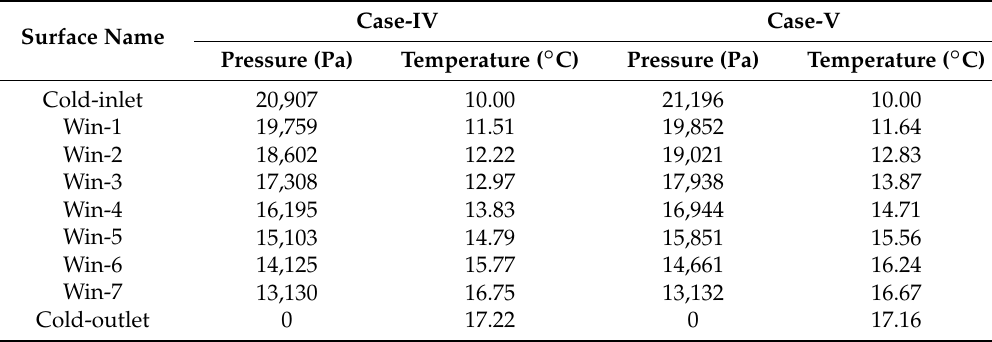
Table 5. Computed temperature and pressure values at different surfaces (ii).